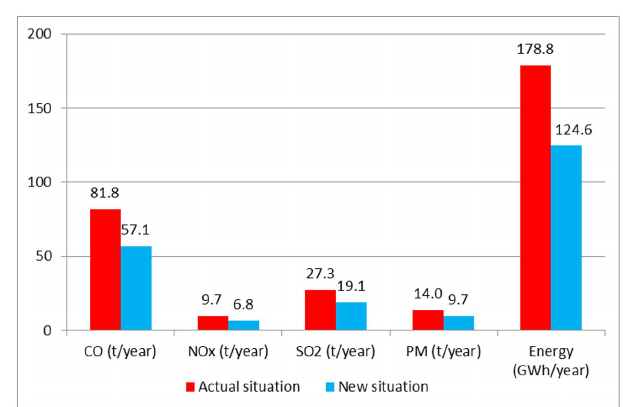
Figure 2. Evaluation of the results of a mathematical model for the population of